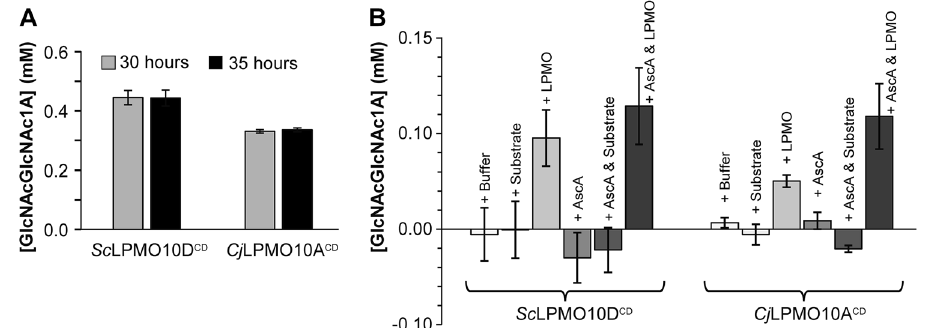
Figure 6. Probing the cause of inactivation of Sc LPMO10D CD and Cj LPMO10A CD . In panel A, Sc LPMO10D CD and Cj LPMO10A CD were incubated at 1 μM with 10 g/L β-chitin at 40 °C and pH 6.0 in the presence of 1 mM ascorbic acid. The oxidized dimer was quantified after degradation of the solubilized oxidized products by Sm CHB. ( A ) Demonstrates that for both enzymes, product formation had stopped prior to 30 h of incubation, as no increase in product yield was detected between 30 and 35 h. ( B ) Shows formation of new products upon addition of fresh components to the reactions from ( A ). This was done by splitting the reaction mixtures into six equal portions, to which either buffer, substrate, LPMO, reductant, substrate + reductant, or LPMO + reductant were added, followed by incubation in standard conditions. After 13 h, all reactions were stopped by filtration before treating samples with Sm CHB to convert all soluble oxidized products into dimers (GlcNAcGlcNAc1A). The error bars show ± S.D. (n =